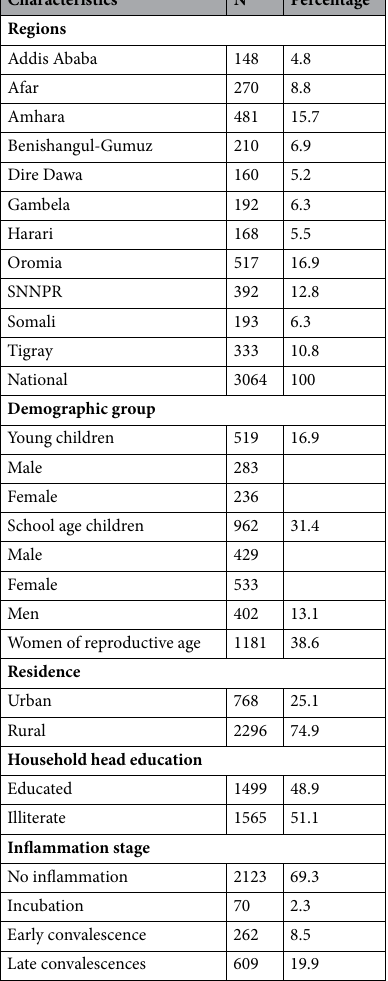
Table 1. Characteristics of study participants in the Ethiopian National Micronutrient Survey (ENMS), 2015. Stages of inflammation were categorized as: no inflammation (CRP ≤ 5 mg L −1 and AGP ≤ 1 g L −1